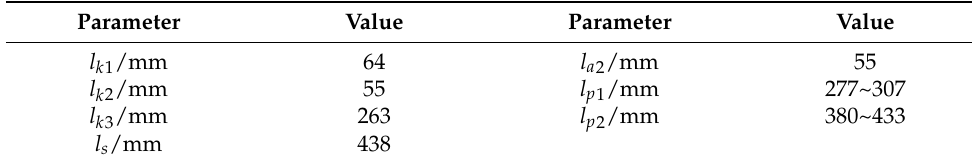
Table 2. Parameters and muscle length range of bionic